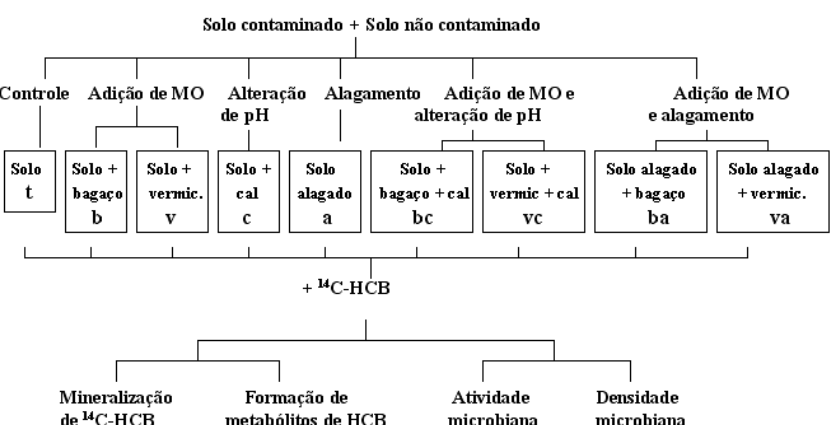
Figura 1. Diagrama esquemático de: tratamentos das amostras de solo contaminado com HCB; mineralização e formação de metabólitos de HCB em solo contaminado; atividade e densidade de microrganismos em solo contaminado com